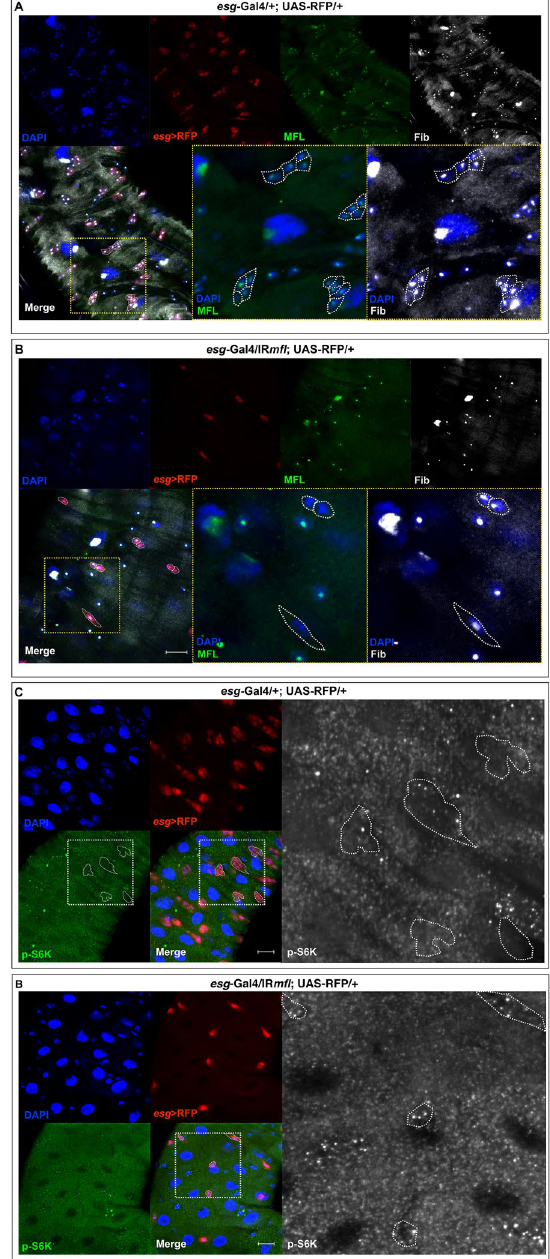
Figure 8. Dyskerin-depleted midgut stem cell precursors do not show growth alterations. Confocal images of third instar larval midguts after immunostaining with anti-MFL, anti-fib and anti- p-S6K. DAPI is in blue; esg expression domain is marked in red by RFP; anti-MFL is in green; anti-fib is in grey; anti-p-S6K is in green (and in grey in the enlargements). Scale bars: 20 µ m. In either control ( A ) and silenced midguts ( B ), MFL and fib co- localize in the nucleolus, as it can be clearly seen in the enlargements of the yellow-dashed squares, where white dotted lines encircle imaginal islands in ( A ) and dispersed esg + cells (doublets or singlets) in ( B ). In control midguts ( C ), immunostaining with anti-p-S6K reveals a very low accumulation level in cells composing the imaginal islands (encircled by a dotted white line in the enlargement); in the silenced midguts ( D ), similar levels were found in esg + singlets and doublets (encircled by a white dotted line in the